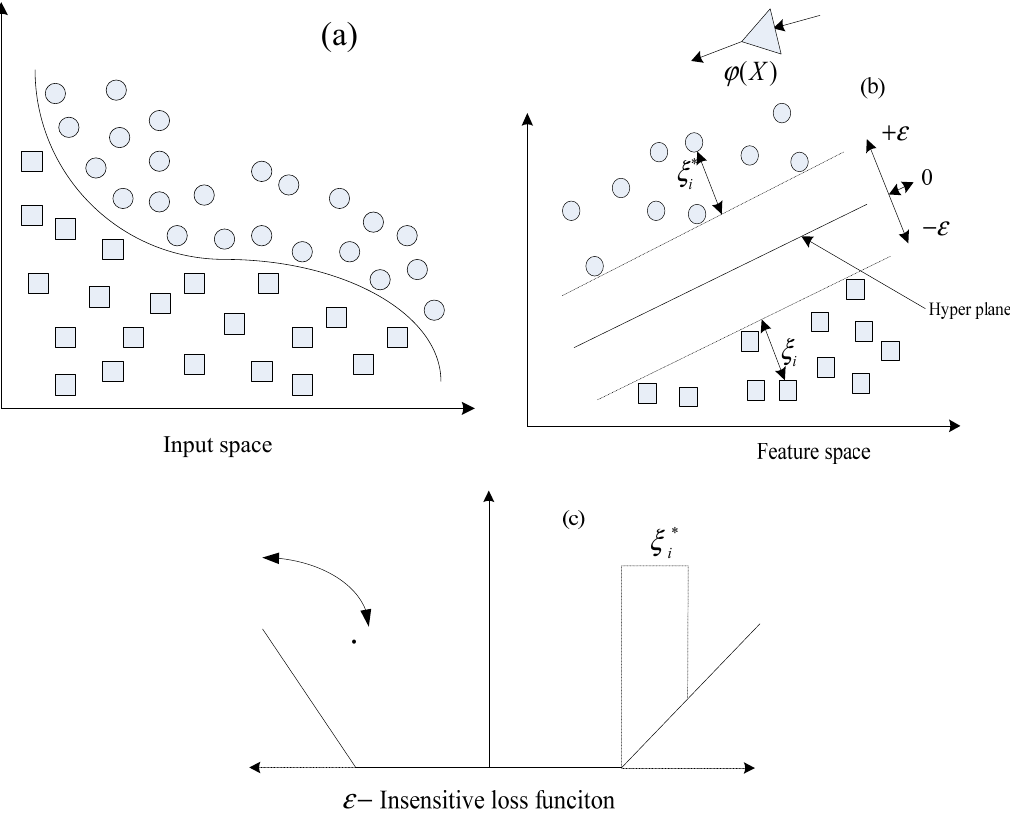
Figure 1. Transformation process illustration of a SVR model. ( a ) Input space; ( b ) Feature space; ( c ) ε -insensitive loss